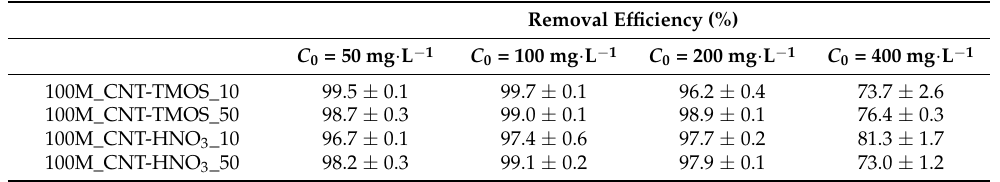
Table 4. Removal efficiency of the carbon nanotubes–silica aerogel composites with two amounts of carbon nanostructure for different initial concentrations of